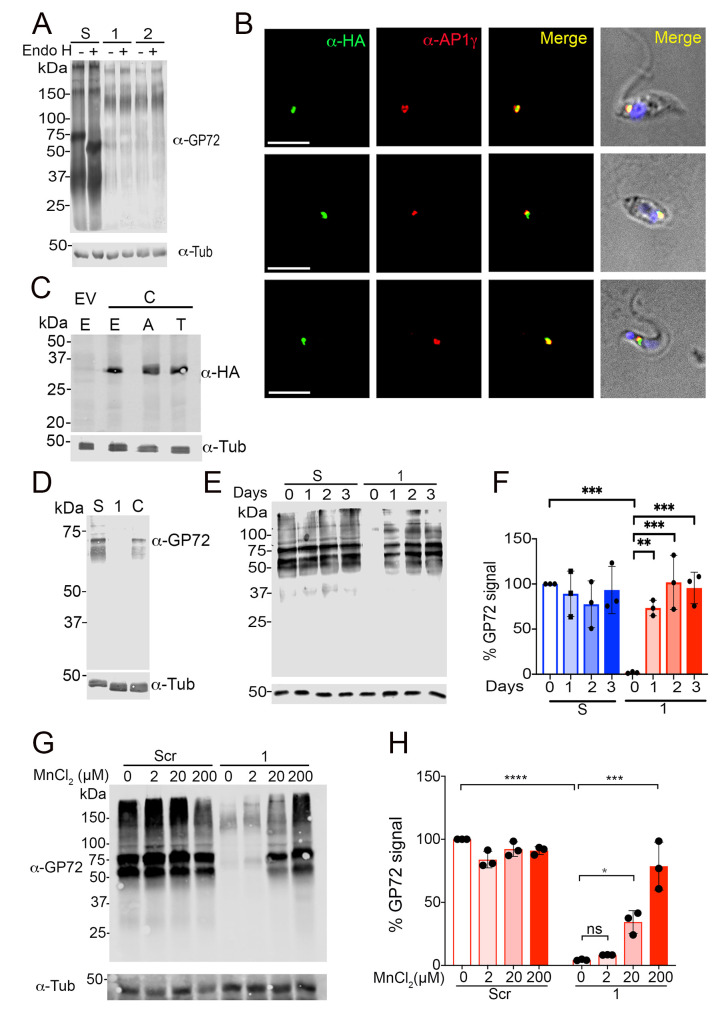
Manganese rescue of protein glycosylation defect.(A) Western blot analysis using WIC29.26 antibody in epimastigotes of control (S) or TcGDT1-KO clones 1 and 2 either untreated or treated with endoglycosidase H (endo H). The 72 kDa band corresponding to GP72 is the predominant band detected by WIC29.26 antibody and migrates faster upon endo H treatment indicating that GP72 is a glycosylated protein. The 72 kDa band and the smearing of the control lanes (S) disappear in the TcGDT1-KO clones indicating reduced glycosylation. Note that the lane appears different from those shown in E because the gel was run for 1 h and at higher voltage. (B) Immunofluorescence analysis (IFA) shows colocalization of TcGDT1(ΔPAM)-3xHA (green) and AP1-gamma (red) in the merged image (yellow) in epimastigotes (upper panels), amastigotes (middle panels), and trypomastigotes (lower panels). Bars = 5 μm. (C) Complementation of TcGDT1-KO clone 1 with TcGDT1(ΔPAM)-3xHA in epimastigotes [E], amastigotes [A] and trypomastigotes [T] was confirmed by western blot analysis using anti-HA monoclonal antibodies, and pTREX empty vector (EV) as control cell line. Tubulin (Tub) was used as loading control. (D) Western blot analysis using WIC 29.26 antibody in epimastigotes of control (S), TcGDT1-KO clone 1, and complemented TcGDT1-KO clone 1. The 72 kDa band corresponding to GP72 and the smearing of the lanes of the control (Scr) disappear in the TcGDT1-KO clone 1 and are partially restored in the complemented clone. Anti-tubulin was used as loading control. (E) Western blot analysis using WIC 29.26 antibody in epimastigotes of control (S) or TcGDT1-KO clone 1 untreated or treated with 20 μM MnCl2 for one, two or three days, before protein extraction and SDS-PAGE. The 72 kDa band corresponding to GP72 and the smearing of the lanes of control (S) disappear in the TcGDT1-KO clone 1 untreated with MnCl2. However, the bands gradually return to the control level by treatment with MnCl2 for increasing periods of time. Anti-tubulin (Tub) was used as loading control. (F) The intensity of bands in (E) was quantified by normalizing GP72 signal to the tubulin signal and expressed graphically as a percentage of signal from the control. Values are means ± s.d., n = 3, **p < 0.01; ***p < 0.005. Statistical analyses were performed using one-way ANOVA and Turkey’s multiple comparisons test. (G) Western blot analysis using WIC 29.26 antibody in control (Scr) or TcGDT1-KO clone 1 epimastigotes untreated or treated with indicated concentrations of MnCl2 for a period of 24 hours before protein extraction and SDS-PAGE. The 72 kDa band corresponding to GP72 and the smearing of the lanes of control (Scr) are greatly reduced in the TcGDT1-KO clone 1 untreated with MnCl2. However, these bands gradually return to the control level by treatment with increasing concentration of MnCl2. Anti-tubulin was used as loading control. (H) The intensity of GP72 bands in (G) was quantified by normalizing GP72 signal to the tubulin signal and expressed graphically as a percentage of signal from the control untreated lane. Values are means ± s.d., n = 3, *p < 0.05, **p < 0.01, ***p < 0.005, ****p < 0.001; ns, not significant. Statistical analyses were performed using one-way ANOVA and Turkey’s multiple comparisons test.